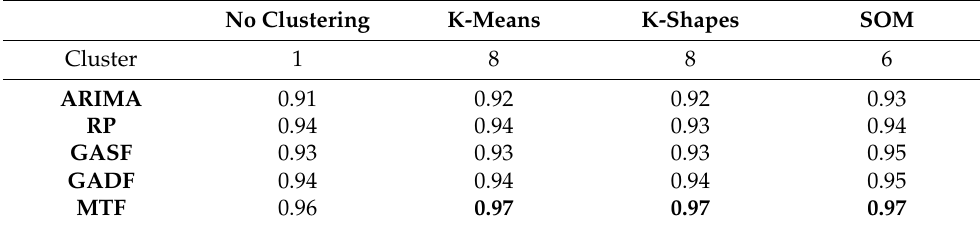
Table 3. Experiment result according to generating time series image and clustering